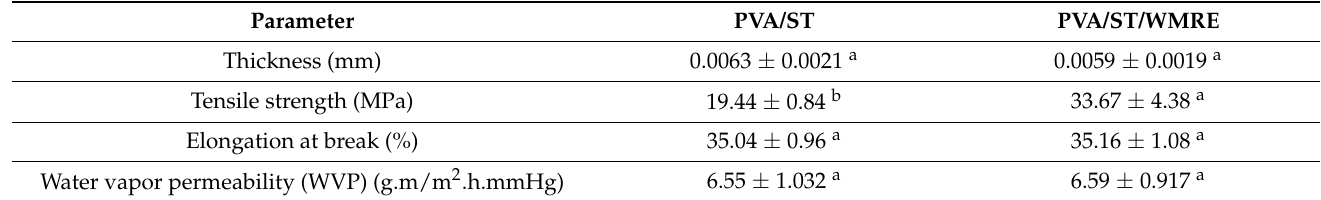
Table 2. Mechanical properties of PVA/ST and PVA/ST/WMRE films. The different letters represent a significant difference of p < 0.05. The error bar indicates the standard deviation (n = 3). Parameter